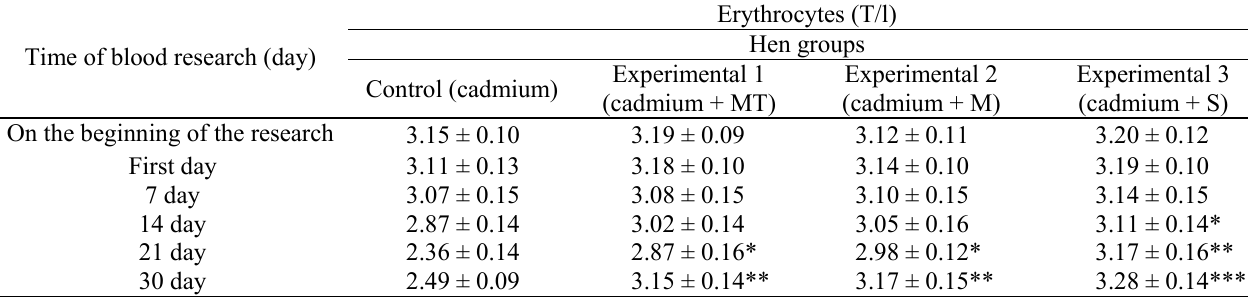
The number of erythrocytes in the blood of laying hens after administration of milk thistle, methifene and silymevit in chronic cadmium toxicosis; (M ± m, n = 8)